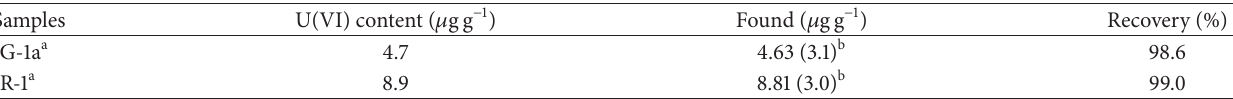
Table 5: Results of the accuracy test of proposed method for U(VI) determination in two geological standard reference materials.